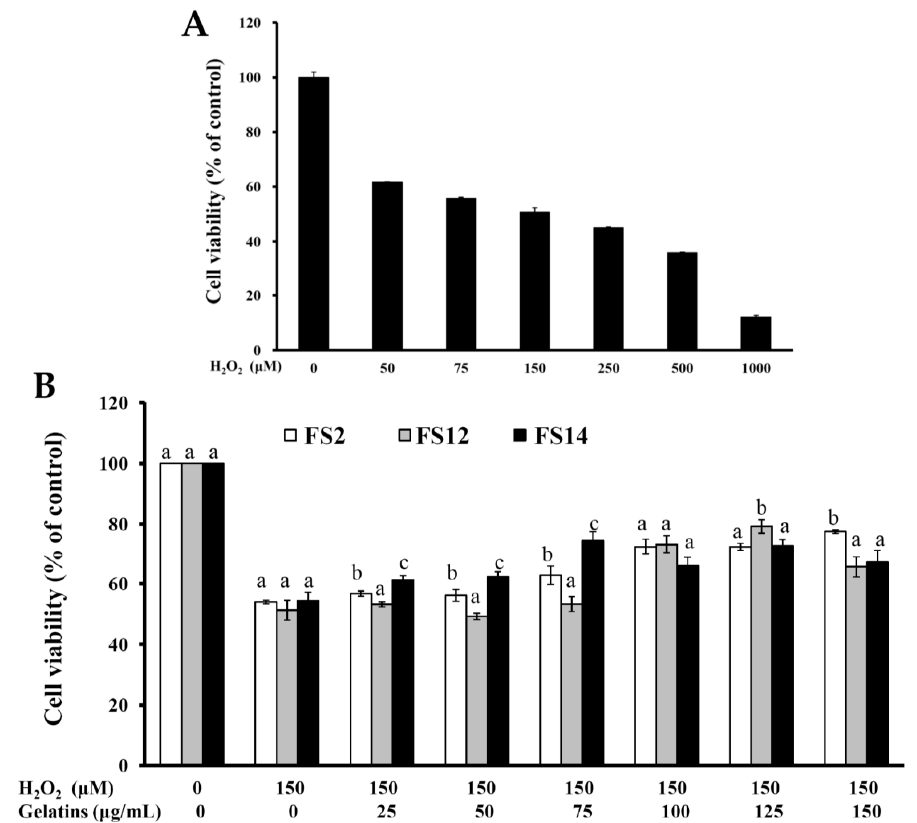
Figure 5. Oxidative protection of FS2, FS12, and FS14 in HaCaT cells. ( A ) HaCaT cells were treated with various concentrations of H 2 O 2 for 24 h, and cell viability was assessed by the MTT assay. ( B ) HaCaT cells were pre-incubated with FS2, FS12, or FS14 (0 to 150 μ g/mL) for 24 h, followed by exposure to 150 μ M H 2 O 2 for 24 h, and cell viability was assessed by the MTT assay. The data are represented as means ± SD ( n = 3). In the same treatment concentration, different letters (in a, b, and c) upon bars indicate significantly different ( p < 0.05).